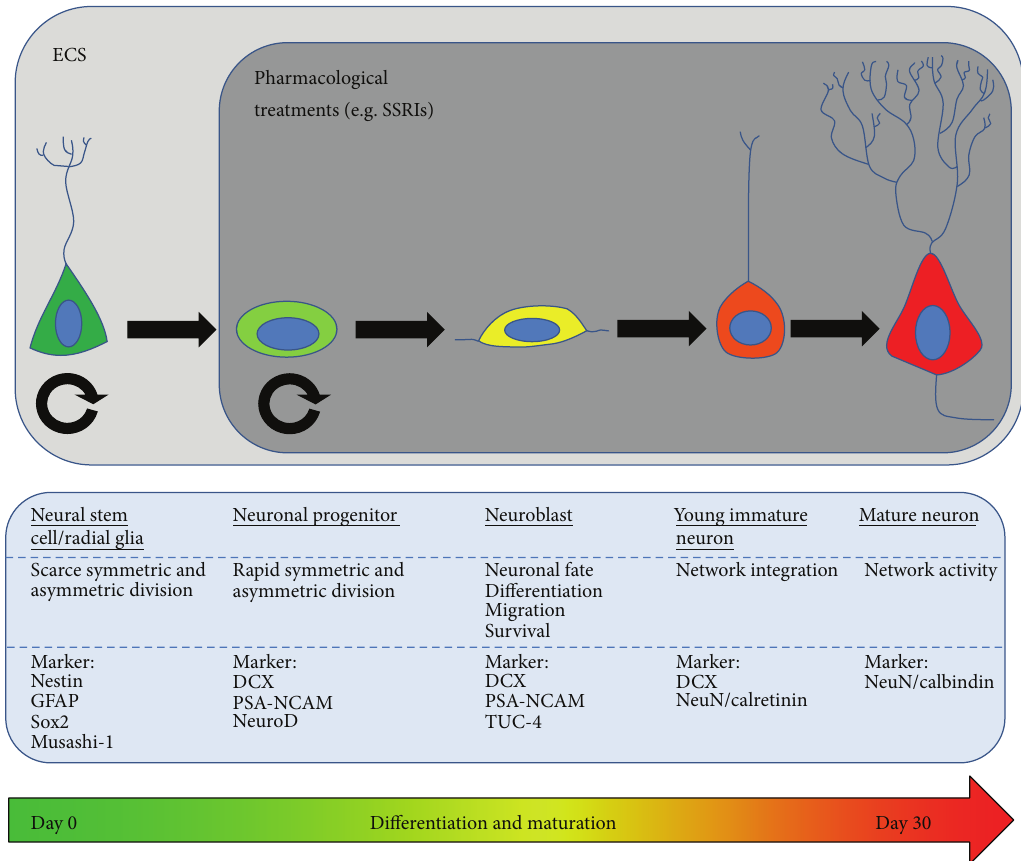
Figure 1: Differentiation and maturation of adult neural stem cells. The process from stem cell division to the fully integrated mature neuron in the dentate gyrus takes approximately 30 days in rodents. Specific markers characterize the various maturation stages (e.g., DCX for neuroblasts). Experimental ECS or pharmacological treatments can influence neurogenesis at various stages; experimental ECS is also reported to activate quiescent stem